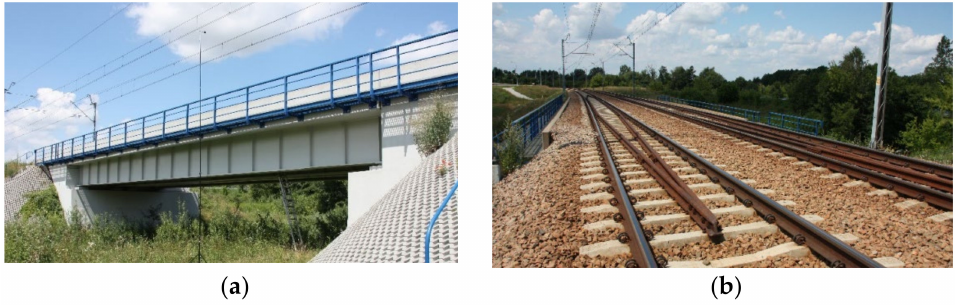
Figure 1. Side ( a ) and top ( b ) view of the tested